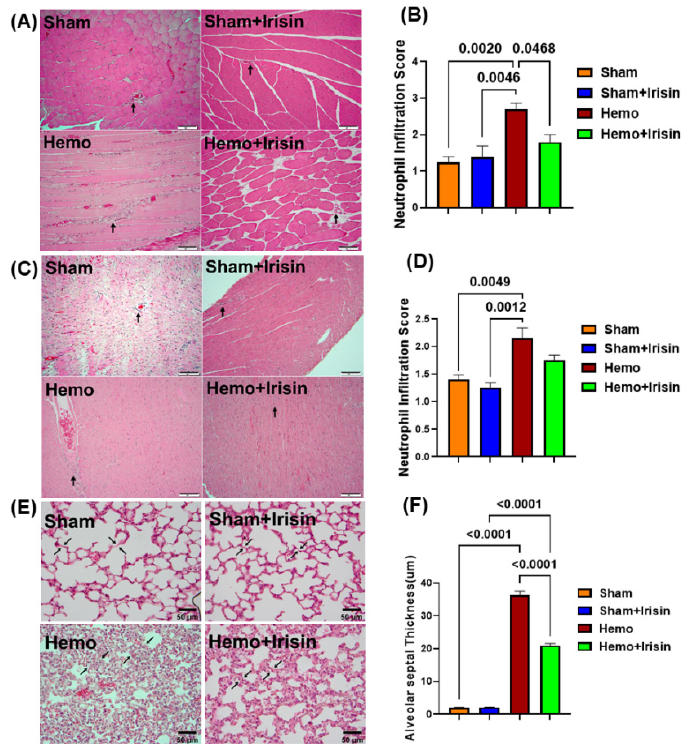
Figure 5. Histological analysis of injury in skeletal muscle, myocardium, and lung. ( A ) Skeletal muscle histology (H&E staining) of sham operated and hemorrhagic groups (200×, scale bars indicate 100 µm); ( B ) A bar graph for data of inflammatory cell infiltration in skeletal muscle (Data are shown as Mean ± SEM, n = 4/each group); ( C ) Cardiomyocyte histology (H&E staining) of sham operated and hemorrhagic groups (200×, scale bars indicate 100 µm); ( D ) A bar graph for data of neutrophilic infiltration in cardiac muscle (Data are shown as Mean ± SEM, n = 4/each group); ( E ) Histopathological images by H&E staining showed pathologic tissue damage in lungs from sham and hemorrhagic groups (H&E staining, original magnification, 400×, scale bars indicate 50 µm). Alveolar sep- tal thickness was used to assess the extent of lung injury; ( F ) A bar graph for data of alveolar septal thickness of the lung (Data are shown as Mean ± SEM, n = 4/each group). Hemo: Hemorrhage.